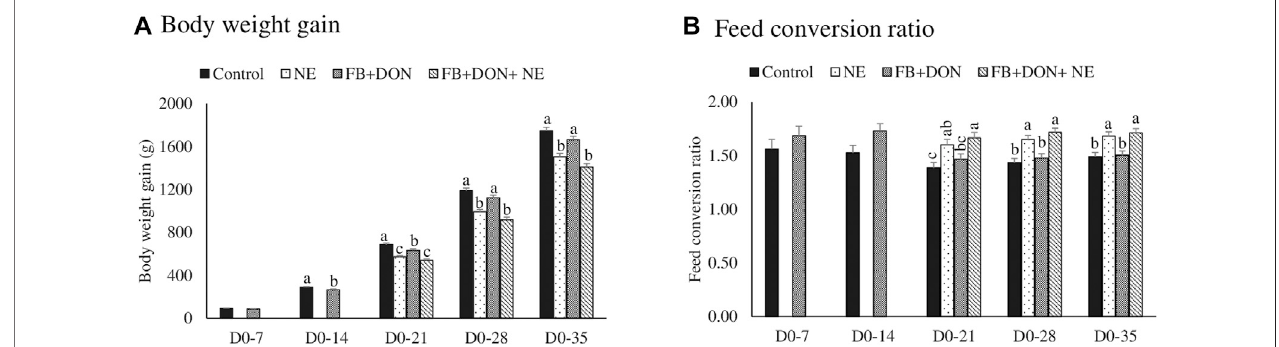
FIGURE1| Effectofsubclinical dose ofFB +DON and E.maxima/C.perfringens challenge on production performances. Day-old chicks were distributed intofour treatment groups: control, necrotic enteritis (NE), fumonisin + deoxynivalenol (FB + DON), and FB + DON + NE groups. Birds in the NE and FB + DON + NE groups received 2.5 × 10 3 Eimeria maxima oocyst per bird on day 14. All birds received 1 × 10 8 CFU/bird of Clostridium perfringens on days 19, 20, and 21. Body weight and feedconsumptionwasmeasuredondays0,7,14,21,28,and35ofagetocalculatebodyweightgain(Panel1A)andfeedconsumptionratio(Panel1B).Mortality- correctedbodyweightgainandfeedconversionratioarepresented.Bars(+SEM)withoutacommonsuperscriptdiffersigni fi cantly( p < 0.05). n =8pensof15birds/pen.